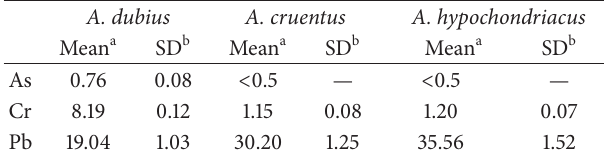
Table 2: Concentration of As, Cr, and Pb in A. dubius , A. cruentus , and A. hypochondriacus